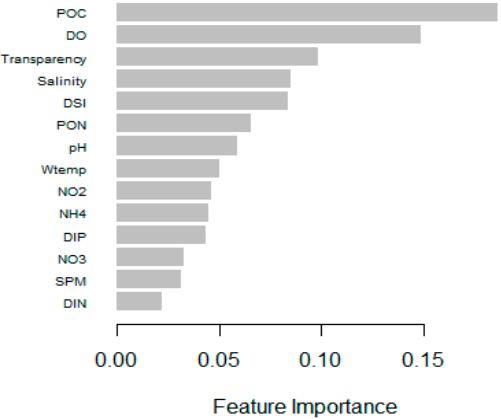
Figure 9. Feature importance using XGBoost. Abbreviations: POC, particulate organic carbon; DO, dissolved oxygen; DSI, dissolved silicate; PON, particulate organic nitrogen; pH, hydrogen ion con- centration in water; Wtemp, water temperature; DIP, dissolved inorganic phosphorus; SPM, sus- pended particulate matter; DIN, dissolved inorganic nitrogen.